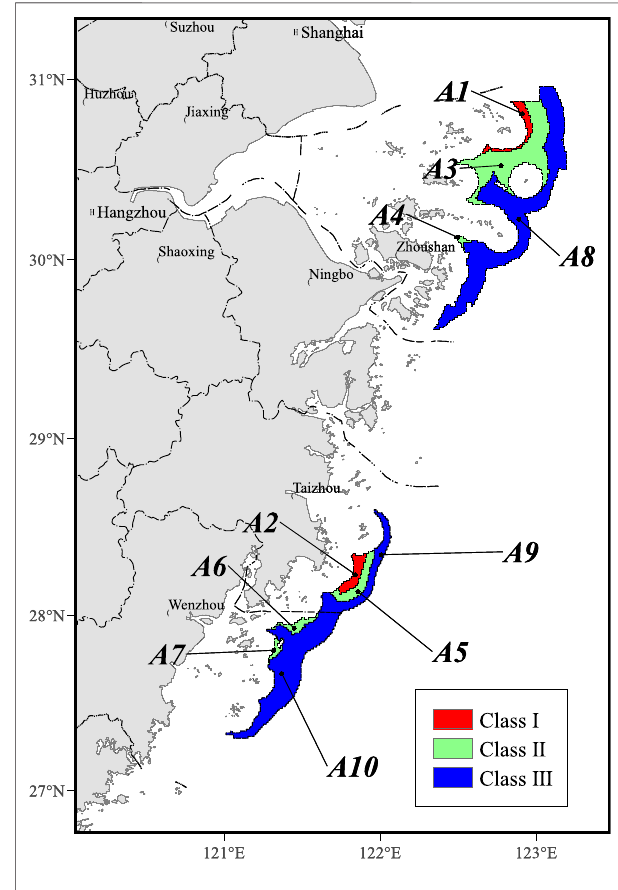
FIGURE 6 | COWWF zoning in Zhejiang